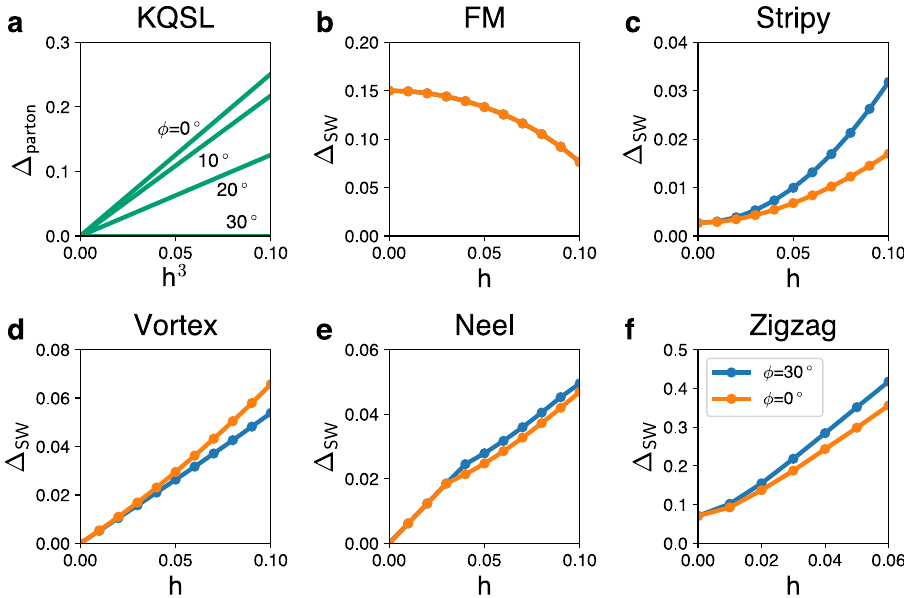
Fig. 4 Comparison of the KQSL with magnetically ordered phases. a KQSL: Majorana energy gap Δ parton as a function of h 3 for the in-plane fi elds, ( θ = 90 ∘ , ϕ = 0 ∘ , 10 ∘ , 20 ∘ , 30 ∘ ), obtained by a parton theory. b – f Ferromagnetic (FM), stripy, vortex, Neel, and zigzag phases: Magnon gap Δ SW as a function of h for the in-plane fi elds, ( θ = 90 ∘ , ϕ = 0 ∘ , 30 ∘ ), obtained with a spin wave theory for the parameter sets # 5~9 in Table 1.